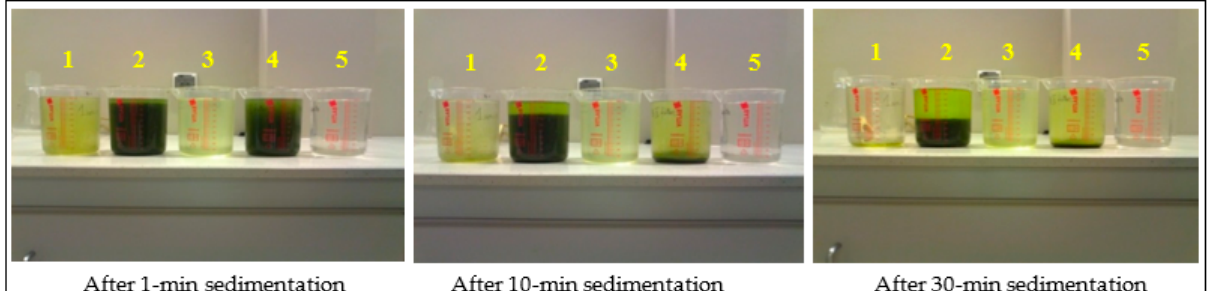
Figure 12. Products of M-BGS separation via 2-stage filtration and sedimentation (1—H-PBR growth medium, 2—M-BGS after 1st filtration pass, 3—effluent after 1st filtration pass, 4—biomass after 2nd filtration pass, 5—effluent after 2nd filtration pass). Table 4. Products of algal biomass filtration.